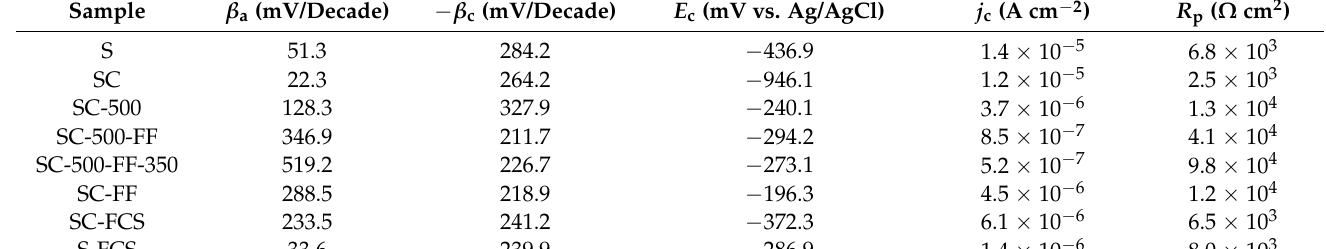
Table 4. Calculated Tafel parameters for samples with different coatings.